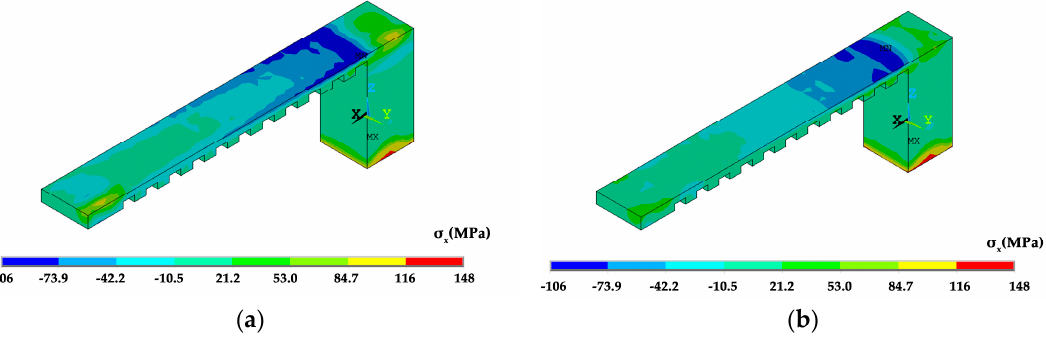
Figure 13. Deformation of the specimen under different scanning strategies as the supports and the far end are removed (deformation magnification 2×): ( a ) the x scanning route; and, ( b ) the y scanning route.